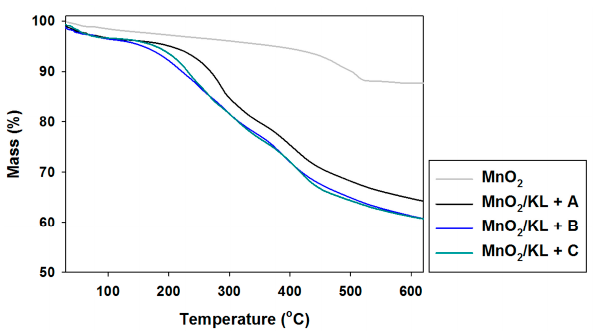
Figure 11. TGA curves of manganese oxide and hybrids obtained by combination of MnO 2 and activated lignins using selected ionic liquids: [C 4 im][HSO 4 ] (MnO 2 /KL+A), [Et 3 NH][HSO 4 ] (MnO 2 /KL+B) and [C 4 C 1 im][MeSO 3 ] (MnO 2 /KL+C).